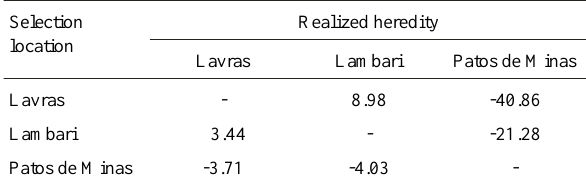
$ h R2 %) tak ing into ac count the